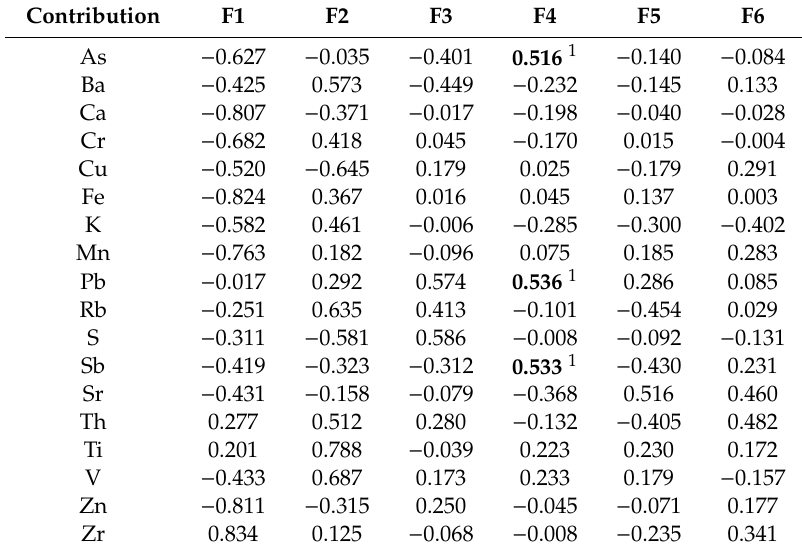
Table 4. Contribution of each element to the six main factors for Ah horizon, clr pXRF measurements.